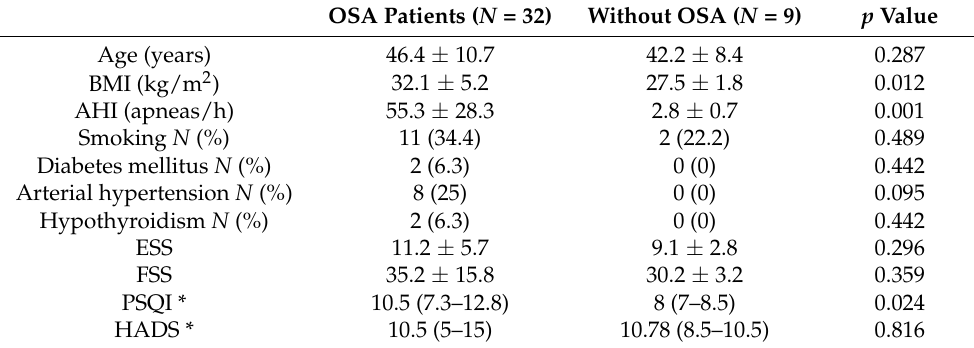
Table 1. Clinical characteristics of the two groups (OSA patients vs. control group without OSA). Mean ± SD, unless otherwise specified.